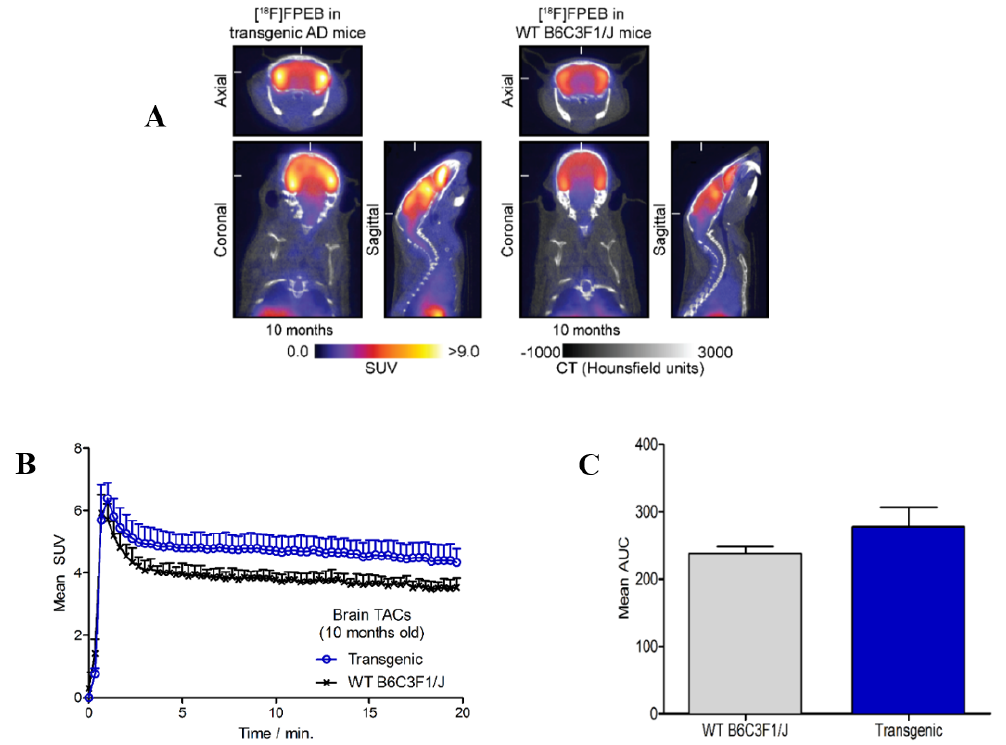
Figure 1. ( A ) PET / CT images of [ 18 F]FPEB 20 min post-injection in 10 month old APP / PS1 (transgenic) Figure 1. ( A ) PET/CT images of [ 18 F]FPEB 20 min post-injection in 10 month old APP/PS1 (transgenic) mice and aged-matched wild-type (WT) B6C3F1 / J (control) mice, n = 3 / group. ( B ) Time–activity curve mice and aged-matched wild-type (WT) B6C3F1/J (control) mice, n = 3 / group. ( B ) Time–activity curve for whole-brain. ( C ) Mean area under the curve for whole-brain. ( C ) Mean area under the curve (AUC).